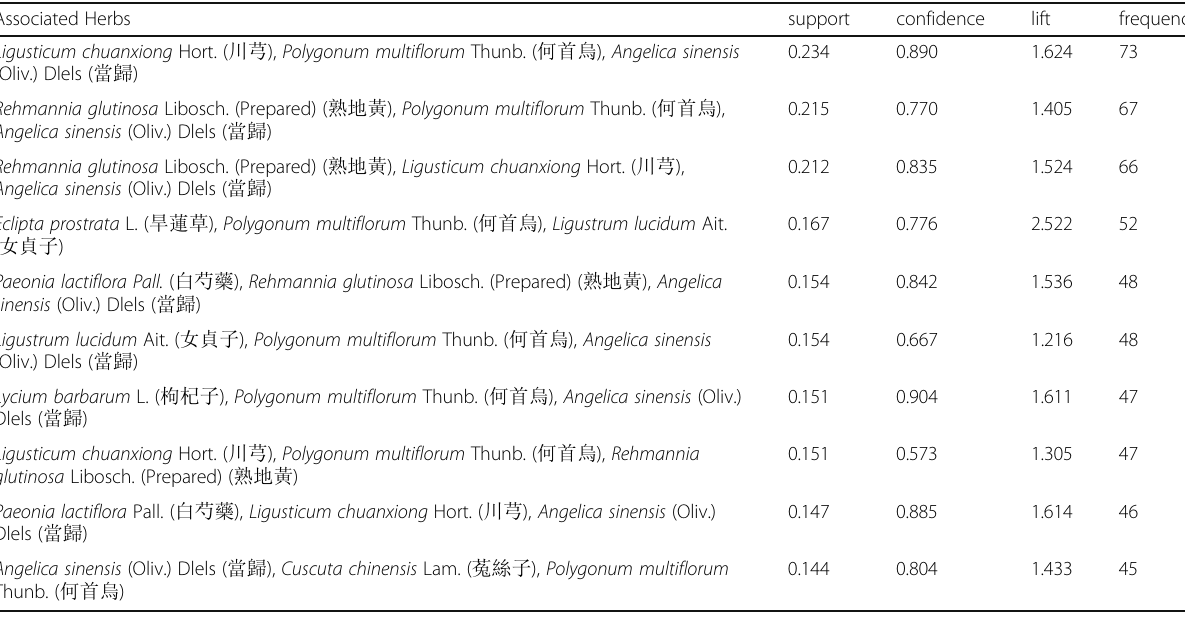
Table 3 Association rule mining results (Length of herb set = 3) Associated Herbs